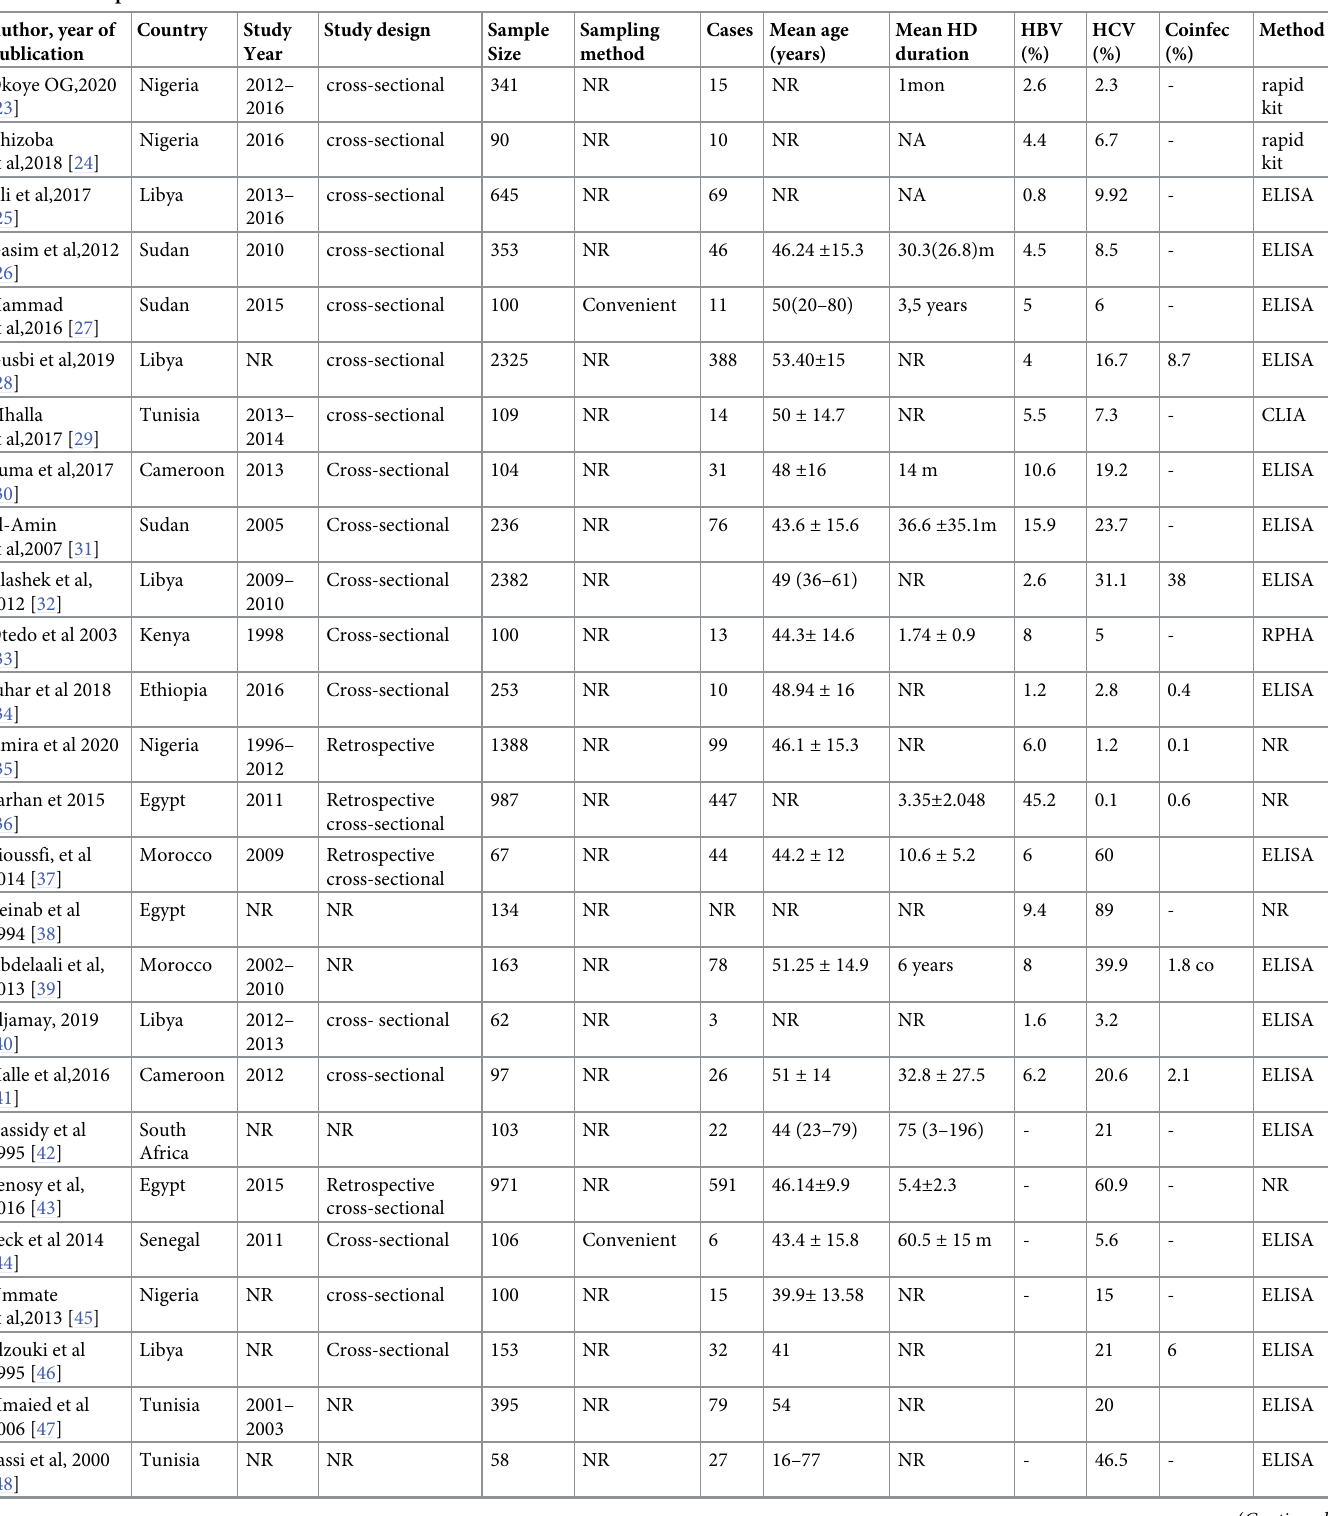
Table 1. Description and outcomes of included